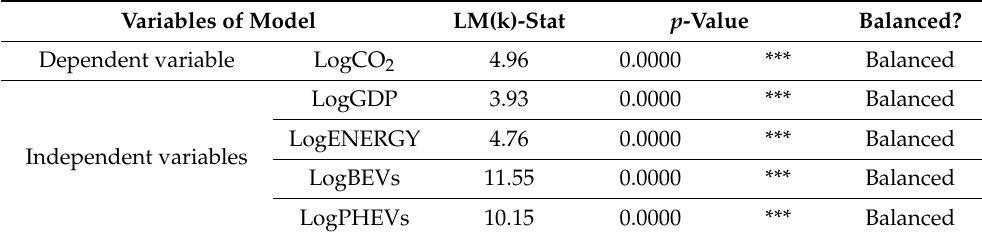
Table 9. Bias-corrected LM-based